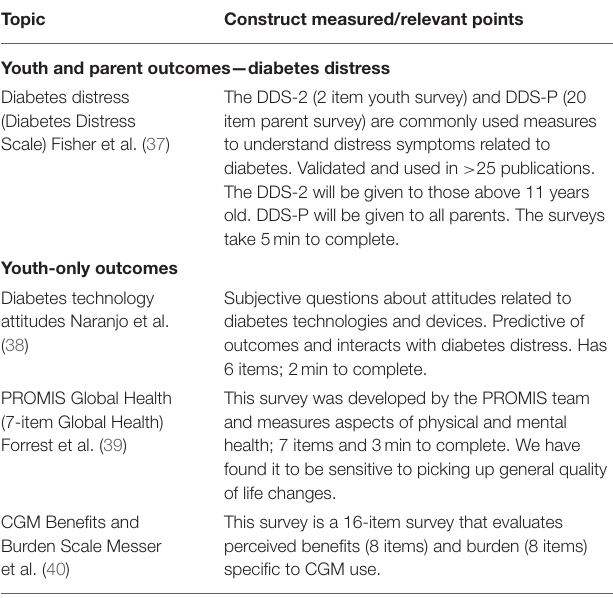
TABLE 2 | Glucose targets from NICE, ISPAD, and ADA